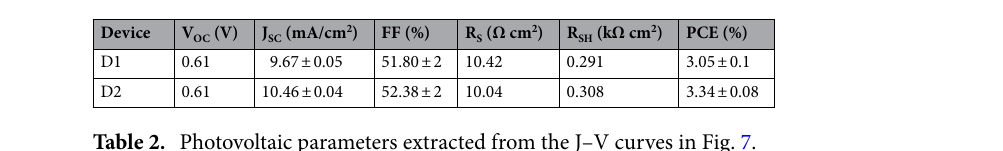
Table 2. Photovoltaic parameters extracted from the J–V curves in Fig.